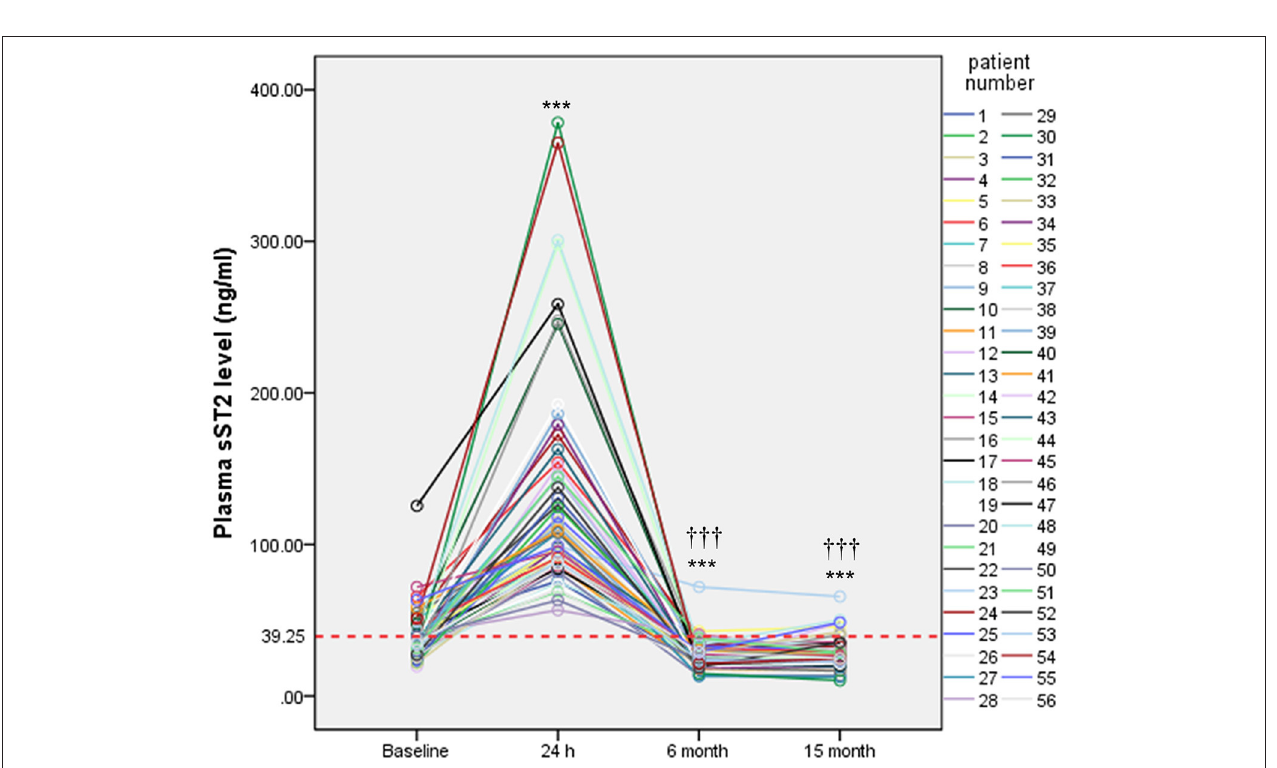
FIGURE 4 | Serial measurements of plasma sST2 in persistent AF patients. Plasma levels of sST2 were measured at baseline, 24h, 6 months, and 15 months after ablation and presented by different color lines. Red lines indicate threshold value for diagnosis. Statistical analysis was performed by repeated measurements analyses of variance. *** P < 0.001 vs. baseline; ††† P < 0.001 vs. 24h.